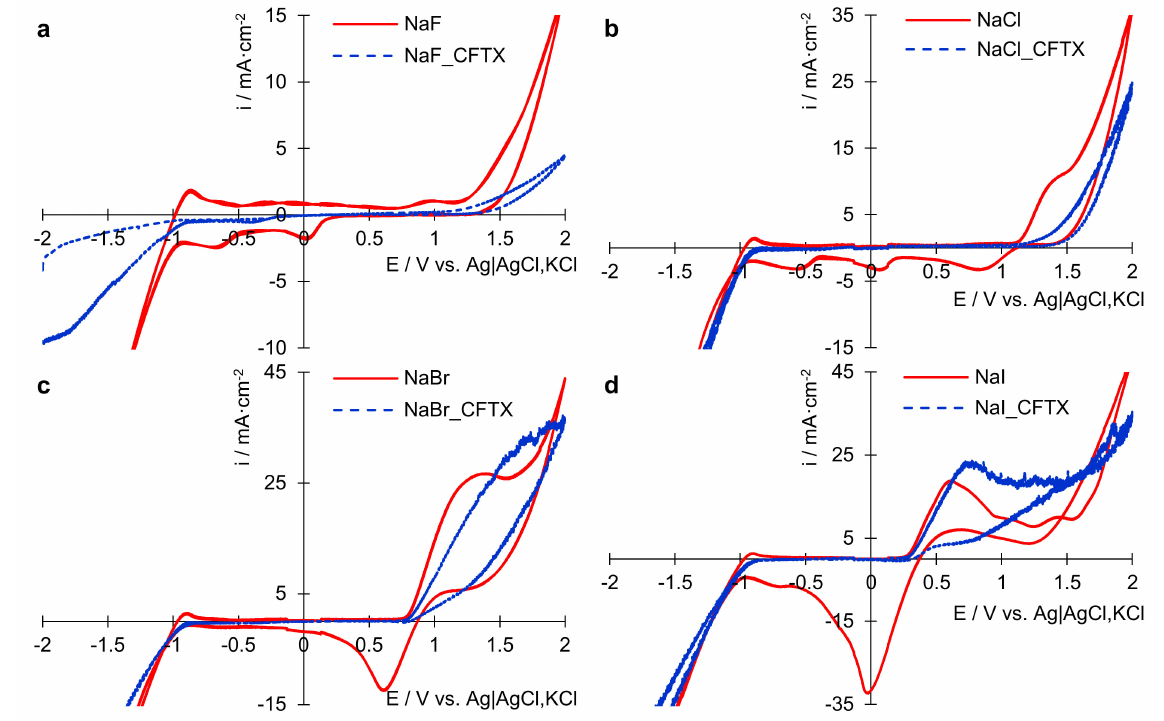
Figure 1. Cyclic voltammograms recorded on platinum electrode in blank support electrolytes and support electrolytes containing 0.025 g · L − 1 CFTX with a potential scan rate of 100 mV · s − 1 : ( a ) 0.1 mol · L − 1 NaF solution without and with CFTX; ( b ) 0.1 mol · L − 1 NaCl solution without and with CFTX; ( c ) 0.1 mol · L − 1 NaBr solution without and with CFTX; ( d ) 0.1 mol · L − 1 NaI solution without and with